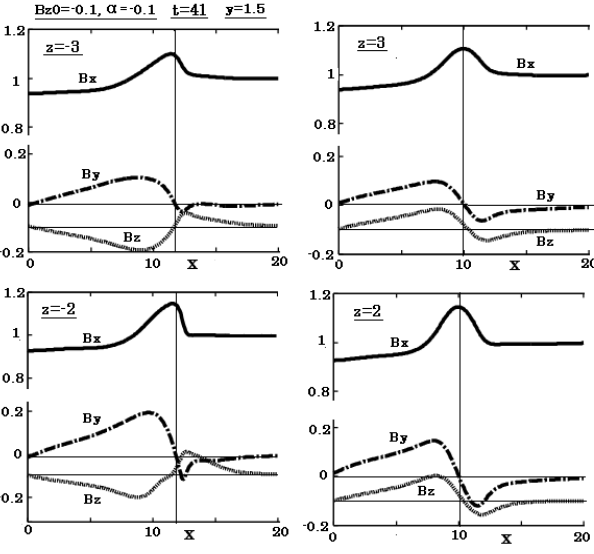
Fig. 13. x-directional profiles of magnetic field components B x ,B y Figure 13: x-directional proflles of magnetic fleld compo- and B z at different locations of z at y = 1 . 5 at time t = 41 for the case of B z 0 =− 0 . 1 and α =− 0 . nents B x ; B y and B z at difierent locations of z at y = 1 : 5 at time t = 41 for the case of B z 0 = 2 : 0 and z = 2 at 1 : 0 at times ¡ ¡ 0 : 1 and fi = 0 : 1, where 0 : 1 and fi = 0 : 2, where ¡ ¡ ¡ ¡